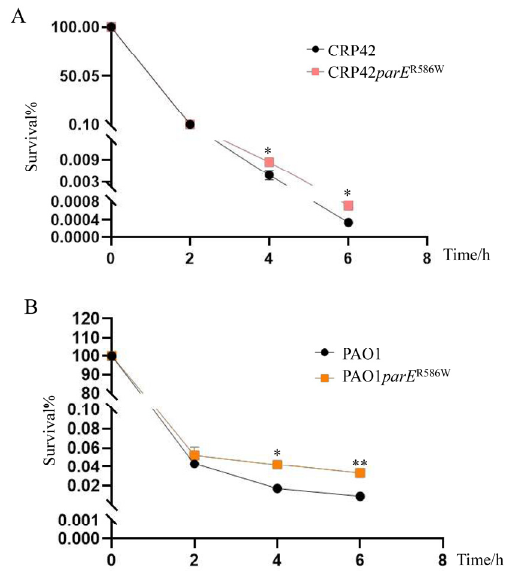
Figure 1. Roles of the ParE R586W mutation in the bacterial tolerance to ciprofloxacin. Bacterial cultures at an OD 600 of 1.0 were treated with ( A ) 16 µ g/mL and ( B ) 0.25 µ g/mL ciprofloxacin in LB broth with agitation. Bacterial cells were collected at the indicated time points, and the survival% were determined by serial dilution and plating. The data represent the results from three independent experiments, and the error bars represent standard deviations. *, P < 0.05, **; P < 0.01, by Student’s t